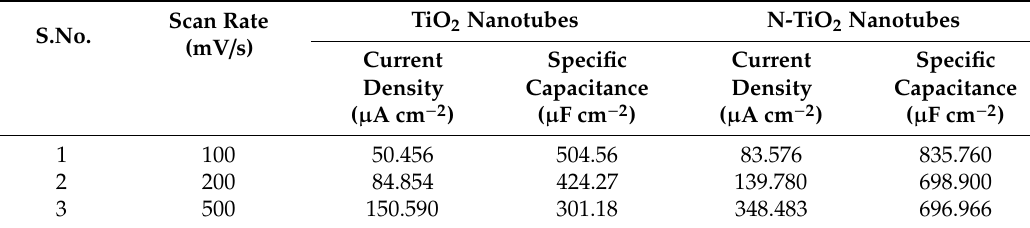
Figure 6. Cyclic voltammetric (CV) curves of ( a ) TiO 2 nanotubes and ( b ) N-TiO 2 nanotubes. Table 1. Displays the current density, and specific capacitance as a function of di ff erent scan